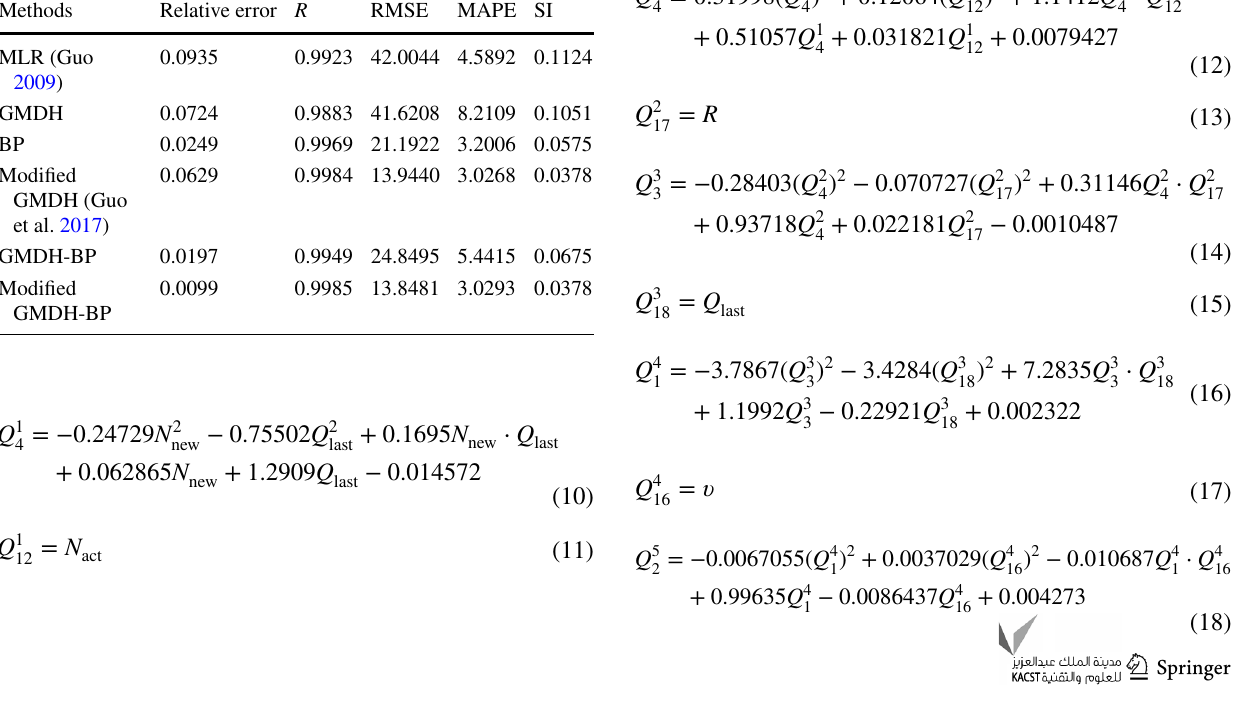
Table 2 Summary of the evaluation results for different models